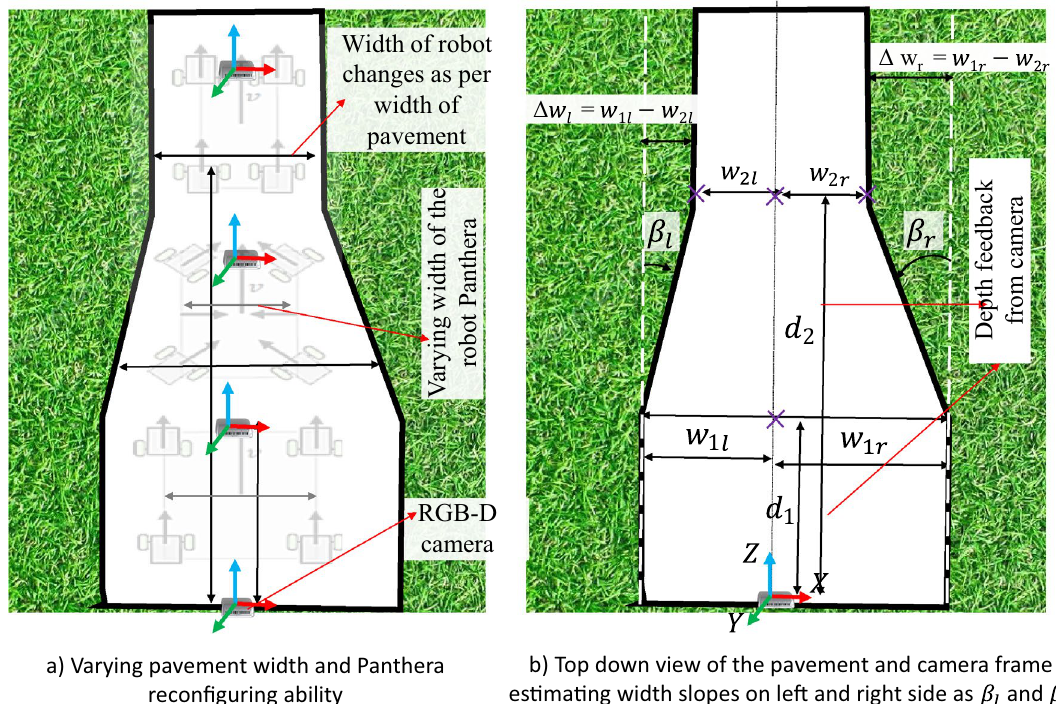
Figure 5. Pavement width estimation using vision feedback for reconfiguration